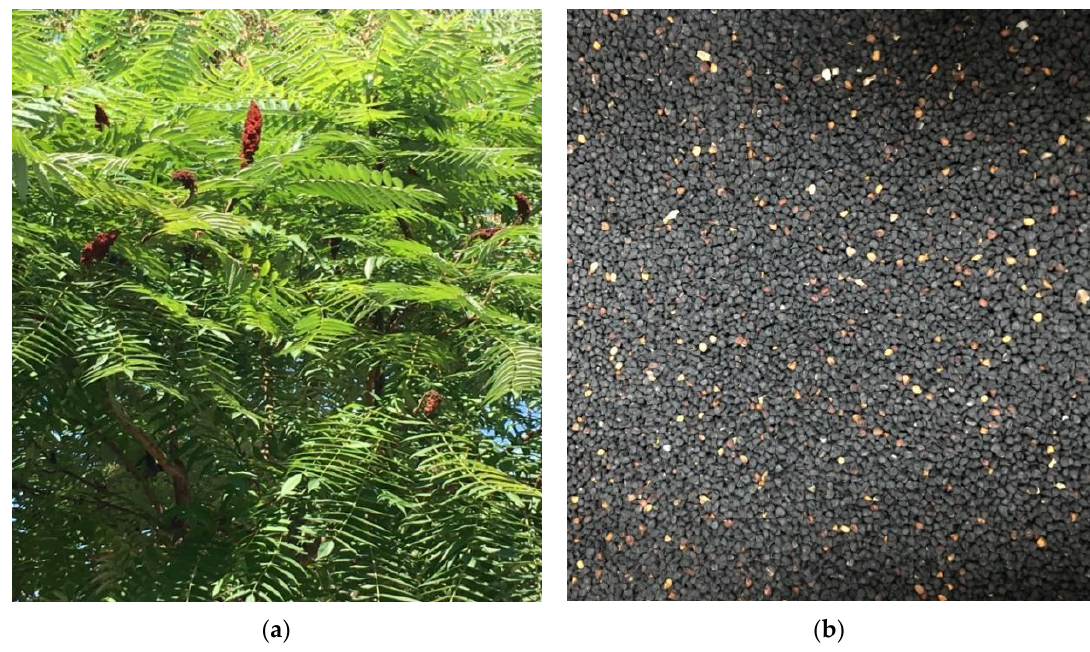
Figure 2. ( a ) Optical photographs of RT mature plant and ( b ) pre-treated seeds. Table 2. FFAs and oil contents of extracted RT seed oil. Solvent FFAs Content (wt. %) Oil Content (wt. %) Petroleum ether 1.0 22 Acetone 1.5 16 Dichloromethane 1.8 14.2 Ethyl acetate 1.3 17.8